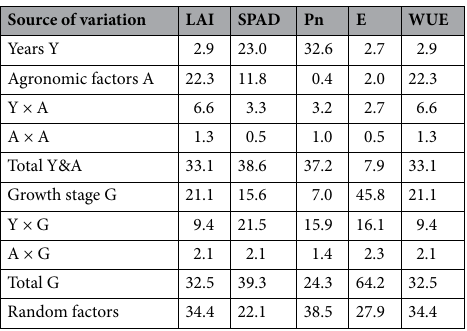
Table 2. Eta-square (η 2 ) values for the sources of variation in the leaf area index (LAI), chlorophyll content (SPAD), net photosynthetic ratio (Pn), transpiration rate (E) and instantaneous water use efficiency